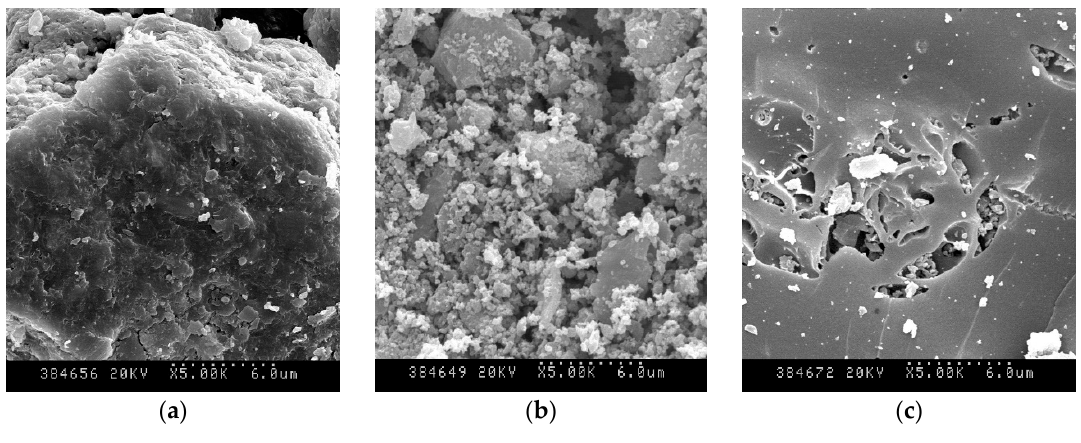
Figure 1. SEM image of ( a ) dried raw sludge, ( b ) SBB and ( c ) PAC.